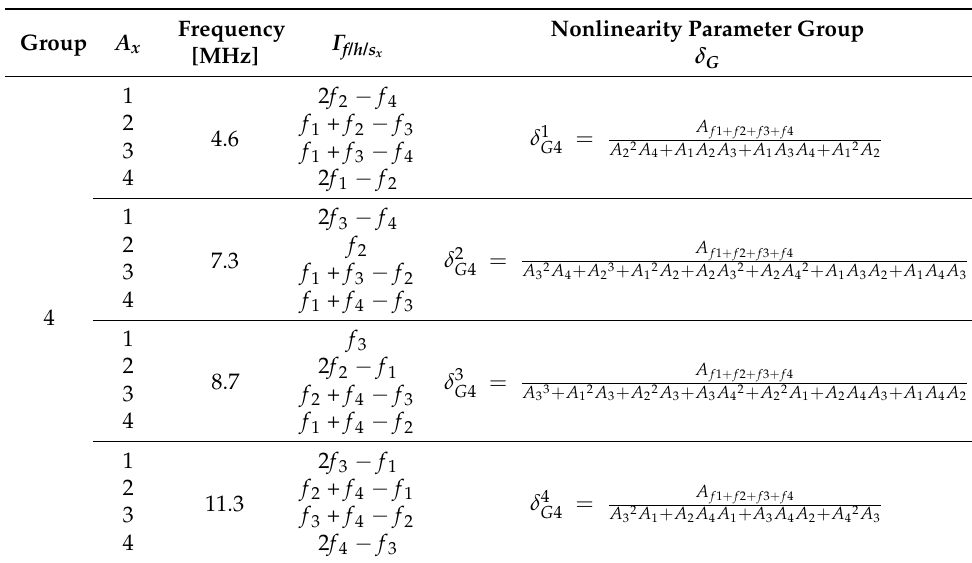
Table 5. Nonlinearity parameter group 4, δ G 4